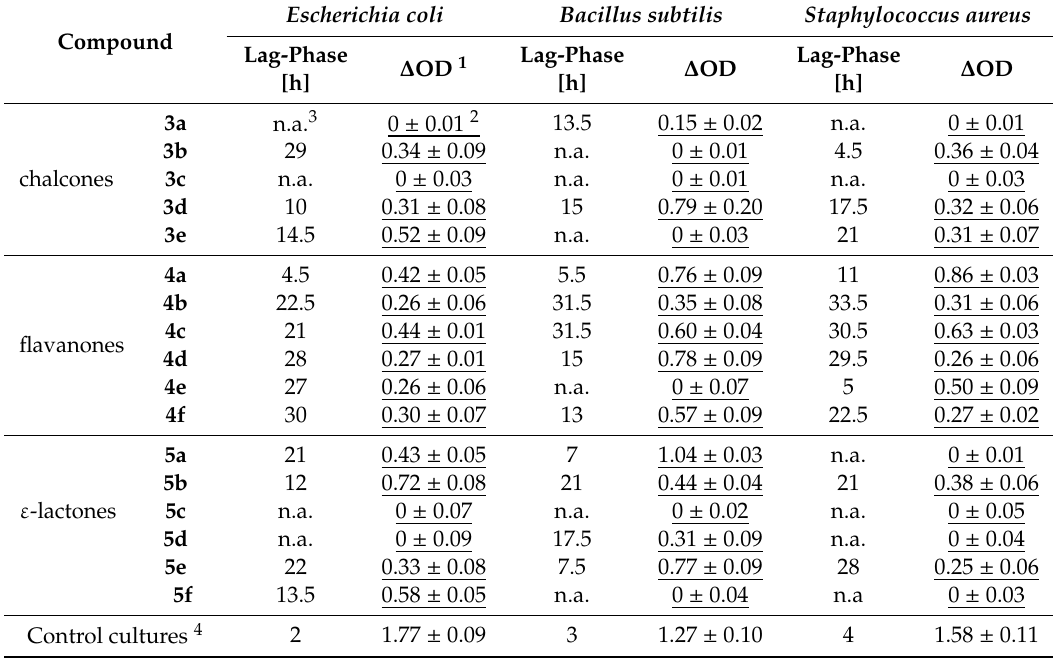
Table 1. E ff ect of chalcones 3a – e , flavanones 4a – f , and ε -lactones 5a – f on the growth of selected bacterial